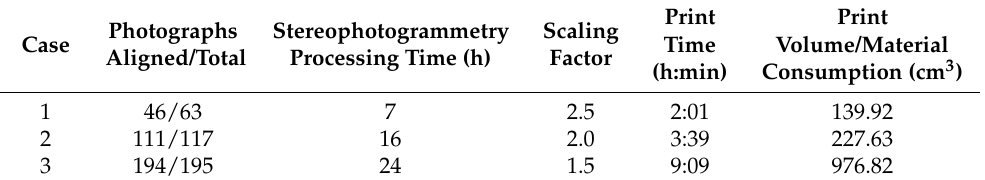
Table 1. Stereophotogrammetry reconstruction details using binder jetting 3D printer.